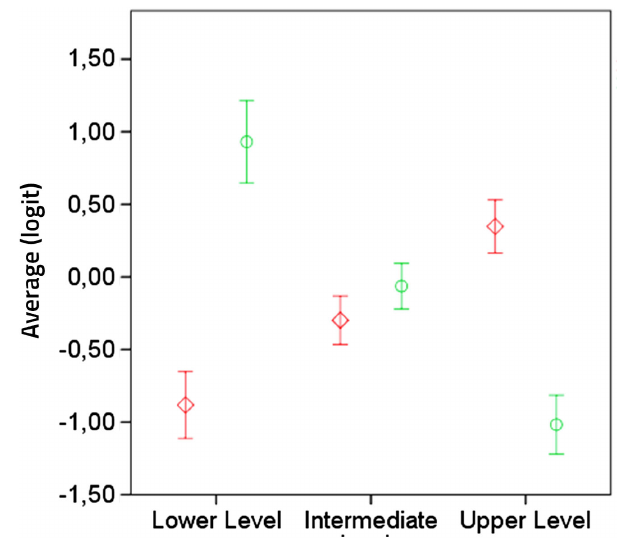
FIG. 9. DPF contrast (green circles) and DPF on confidence items (red diamonds) vs levels of the revised construct map in QM described in Ref. [47] for the whole sample. See Appendix for the definition of the construct map levels. Whiskers indicate 95% confidence interval. Green (red) circles (diamonds) are slightly shifted toward the right (left) to enhance